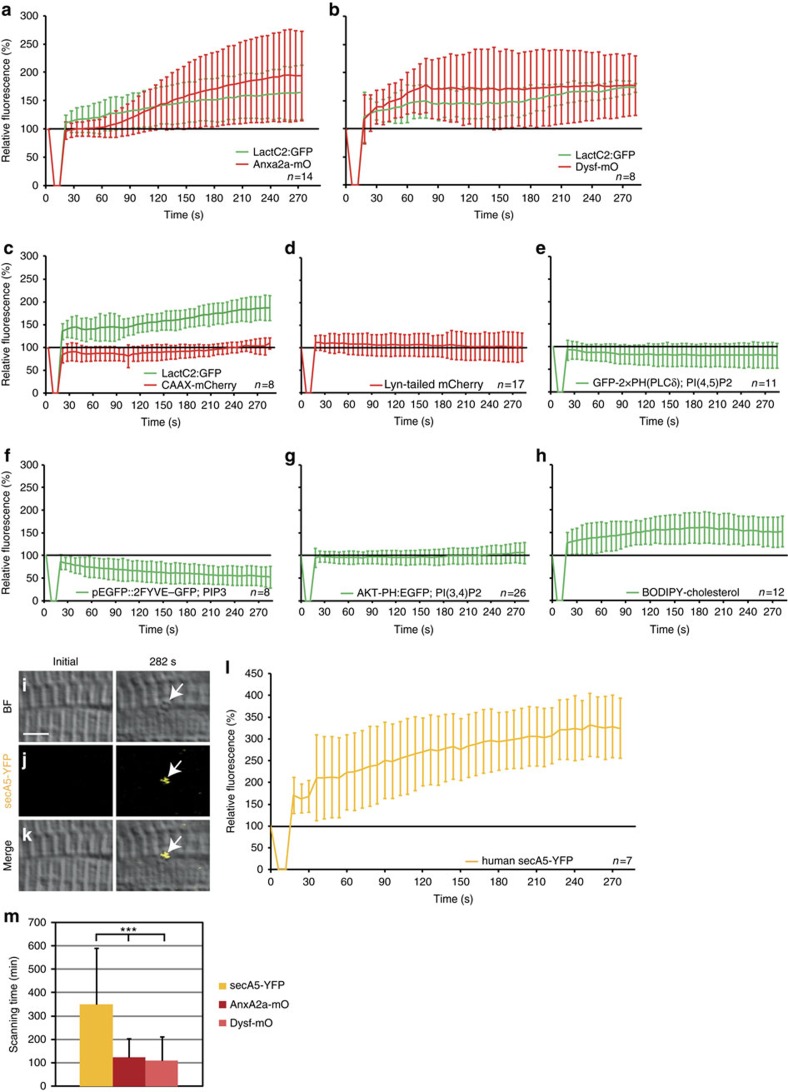
Phosphatidylserine (PS) is sorted to the repair patch.(a–h) Real-time analysis of enrichment of PS (LactC2:GFP (a–c)), PI(4,5)P2 (GFP-2 × PH(PLCδ) (e)), PIP3 (pEGFP::2FYVE–GFP (f)), PI(3,4)P2 (AKT-PH:EGFP (g)) and cholesterol (BODIPY-cholesterol (h)), relative to AnxA2a-mO (a), Dysf–mO (b) and membrane markers CAAX-mCherry (c), Lyn-tailed mCherry (d). The reporter fluorescence is expressed as percentage (mean±s.d.) relative to the level before injury. (i–m) PS is presented on the extracellular side of the repair patch. (i–l) Extracellularly supplied secA5-YFP was enriched at membrane on lesioning (i–k, arrows). secA5-YFP expressing myofibers are outside of the field of view. (l) Kinetics of secA5-YFP at the repair patch. (m) Macrophage scanning-time (+/− s.d.) of myofibers expressing secreted secA5-YFP (yellow, n=19), AnxA2a-mO (dark red, n=22) or Dysf–mO (light red, n=23; Student t-test P<0.001) Scale bar, 4 μm.